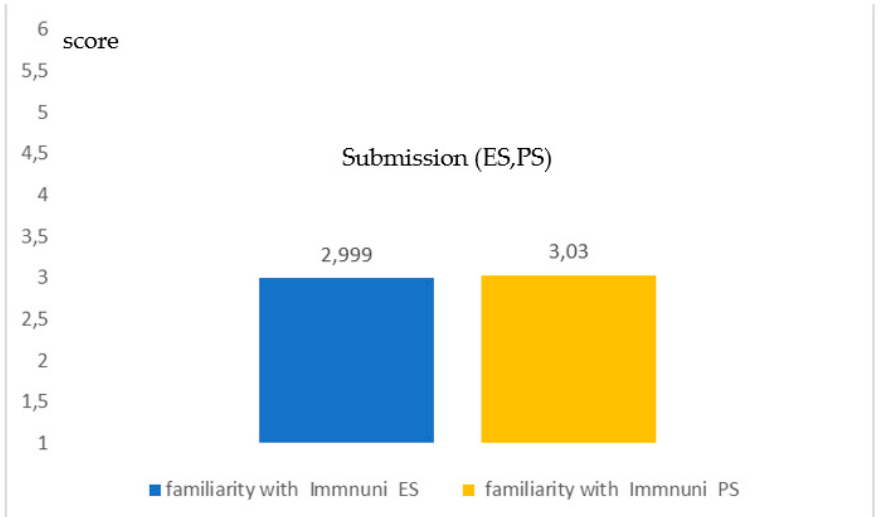
Figure 2. Coherence in the degree of familiarity with social networks, Q16 ( p = 0.217) and messaging Apps, Q17 ( p = 0.237) both for the ES and the PS. The graphic indicates a high coherence between the two groups.